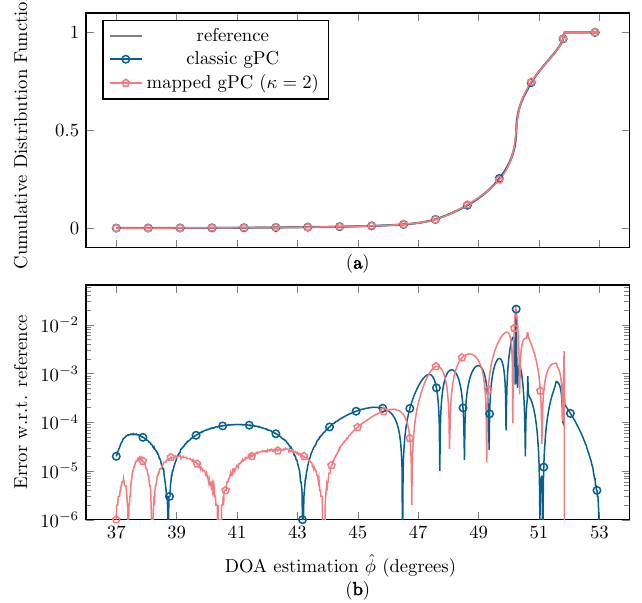
Figure 14. ( a ) The empirical CDFs of ˆ φ when sampling the classic and mapped gPC expansion with the full simulation as a reference, each constructed with LHS and 10 6 samples, with w ( x ) = Beta ( x ;2,2 ) and N = 15. ( b ) The error of the classic and mapped gPC CDFs in comparison to the reference